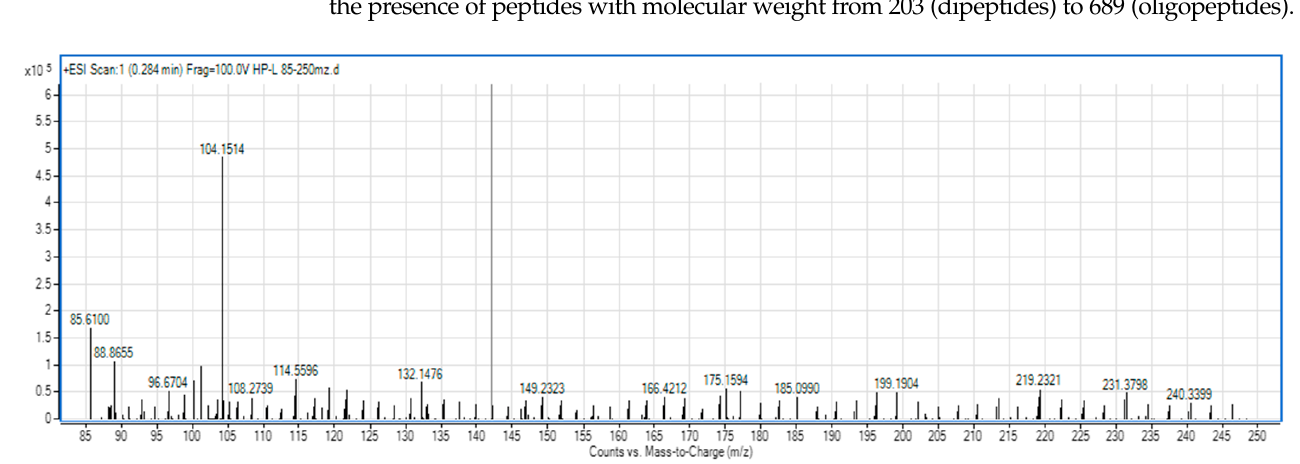
Figure 3. The spectrum of the hydrolysate sample in the domain 85–250 m / z .